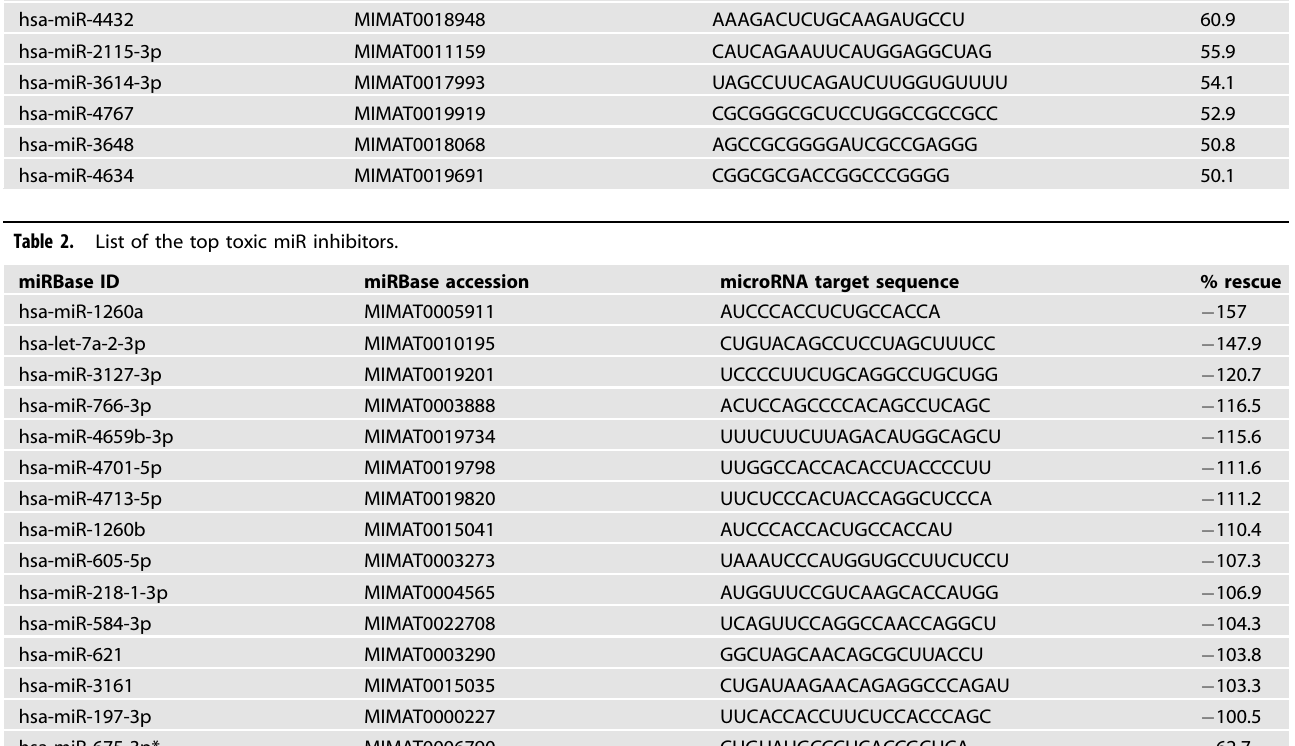
Table 1. List of the top protective miR inhibitors providing >50% rescue of the DUX4-induced myoblast death.